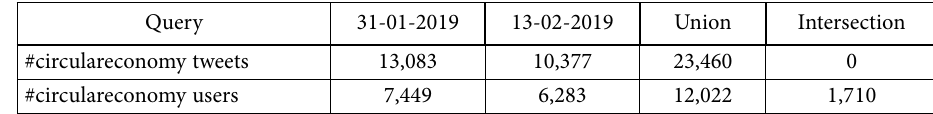
Table 2. Results of the search for relevant Twitter users (source: own study based on Twitter) Query